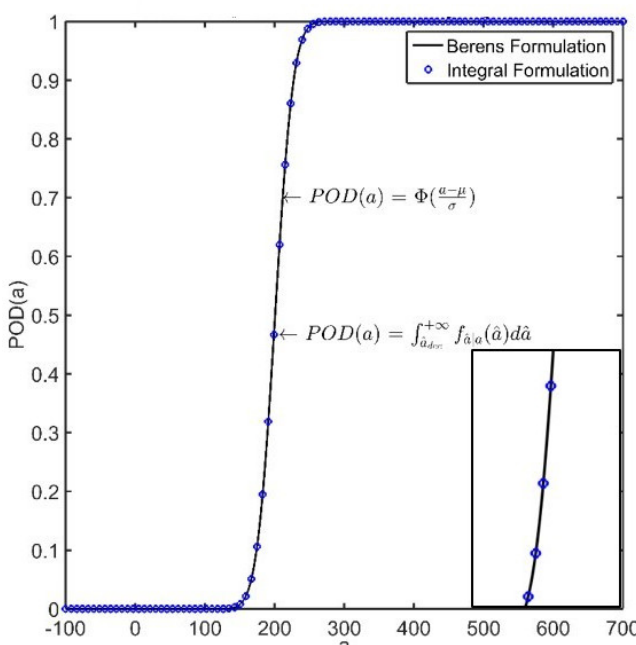
Figure 4. Probability of detection curve versus flaw size, calculated using the ˆ a vs. a procedure with the definition of Berens and integral formulation (illustrative